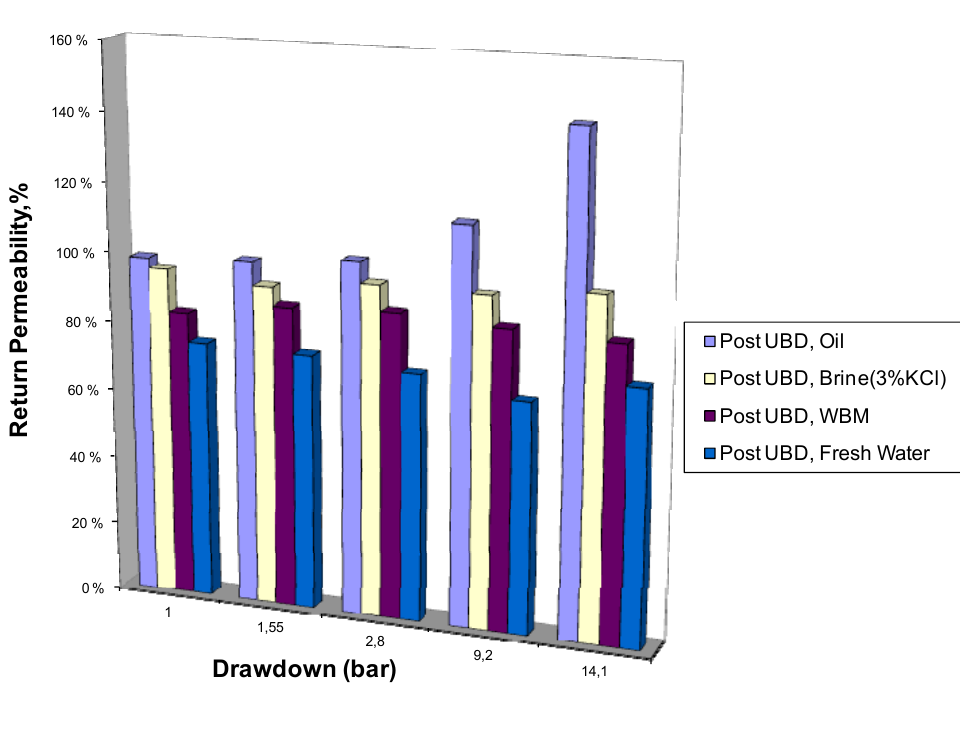
Figure 10. UBD fluid selection.